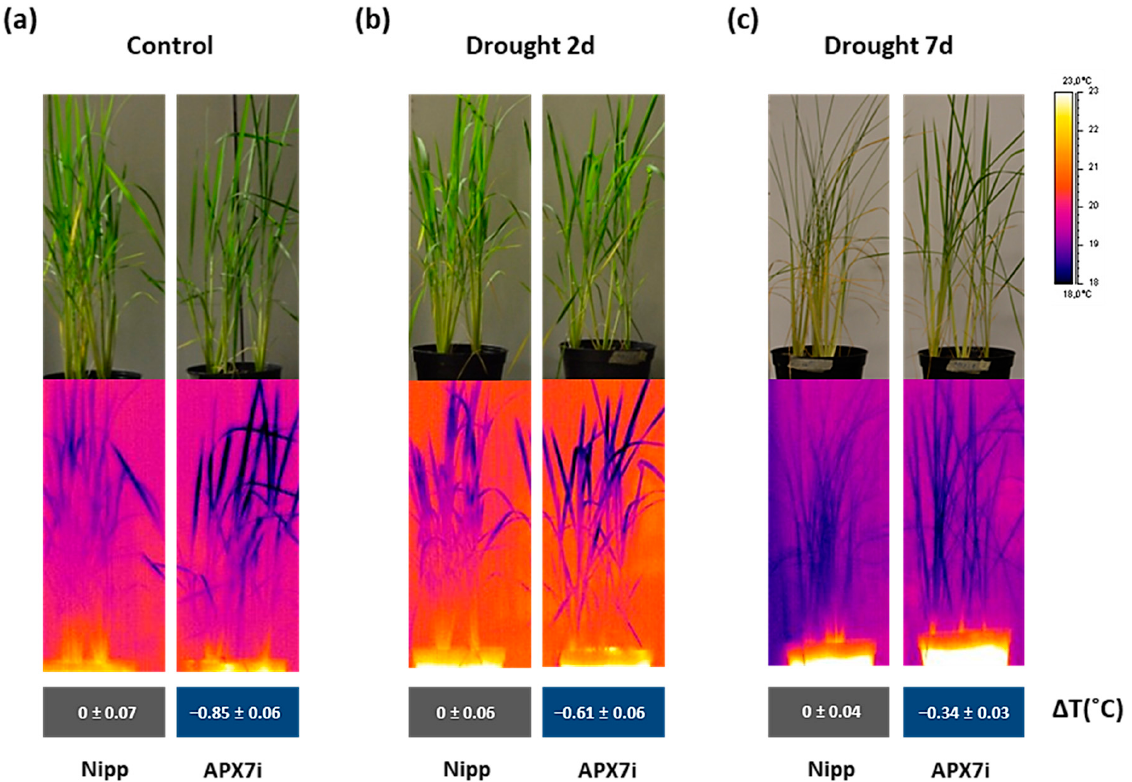
Figure 8. Thermal images of Nipponbare (Nipp) and APX7i captured by an infrared thermography device. ( a ) plants under control conditions, ( b ) plants under 2 days of drought stress, and ( c ) plants under 7 days of drought stress. The values represent the average ± SE of Δ T (°C) of each line to Nipp plants in three independent experiments.